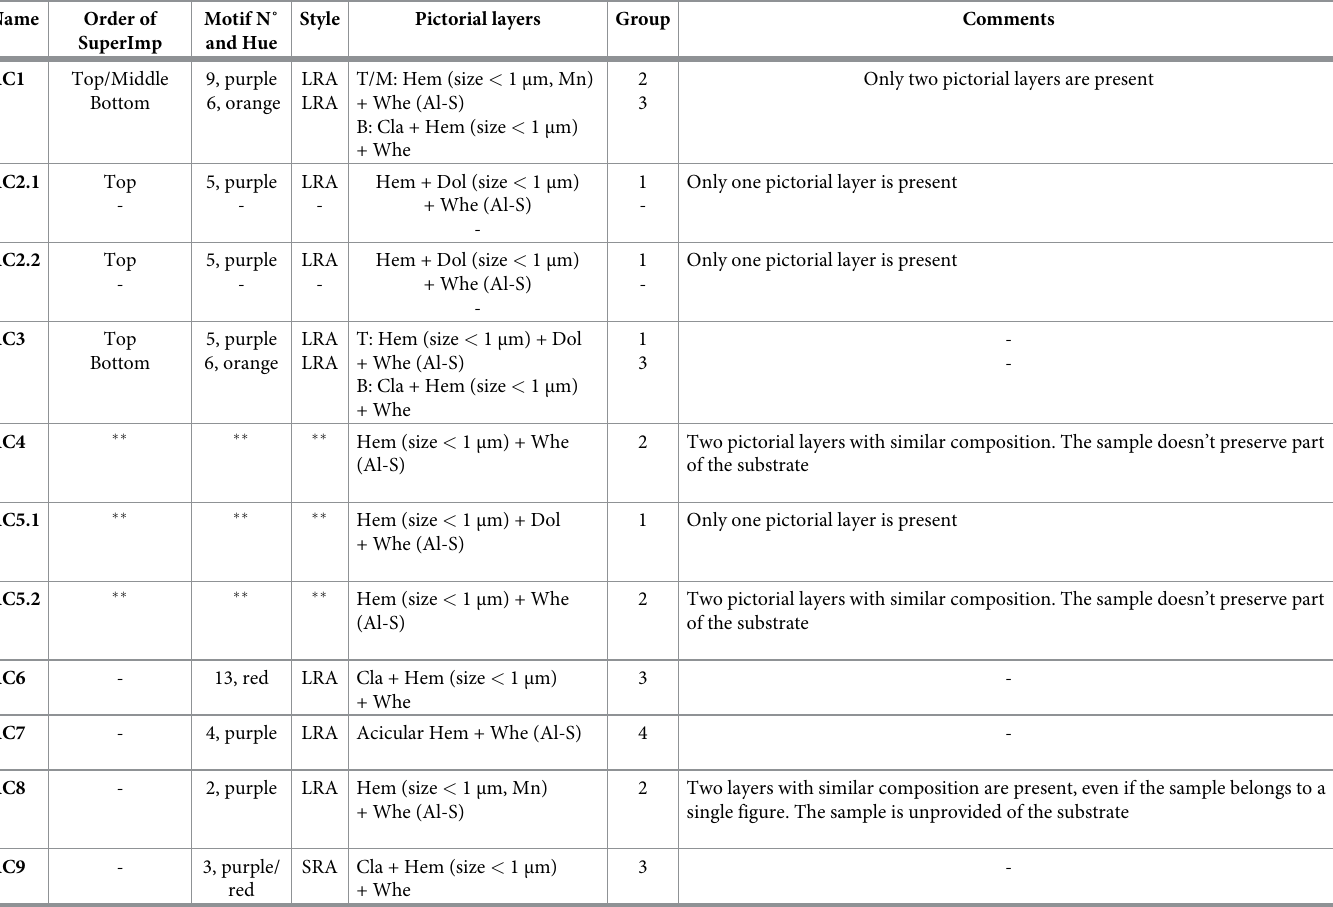
Table 3. Summary of the results achieved by SEM-EDX, micro-Raman and FTIR analyses of the paint layers constituting cross-sections AC1-AC9. Label: SuperImp = superimpositions; LRA = Levantine Rock Art; SRA = Schematic Rock Art; cla = clay matrix; hem = hematite; dol = dolomite; whe = whewellite; Mn = Manganese impurities; (Al-S) = aluminosilicates; the brackets refer to the low amount identified. The results between brackets are occasionally detected. In samples marked with �� , the order of superimpositions among motifs 10 and 11 and the composition of the corresponding single motifs have not been